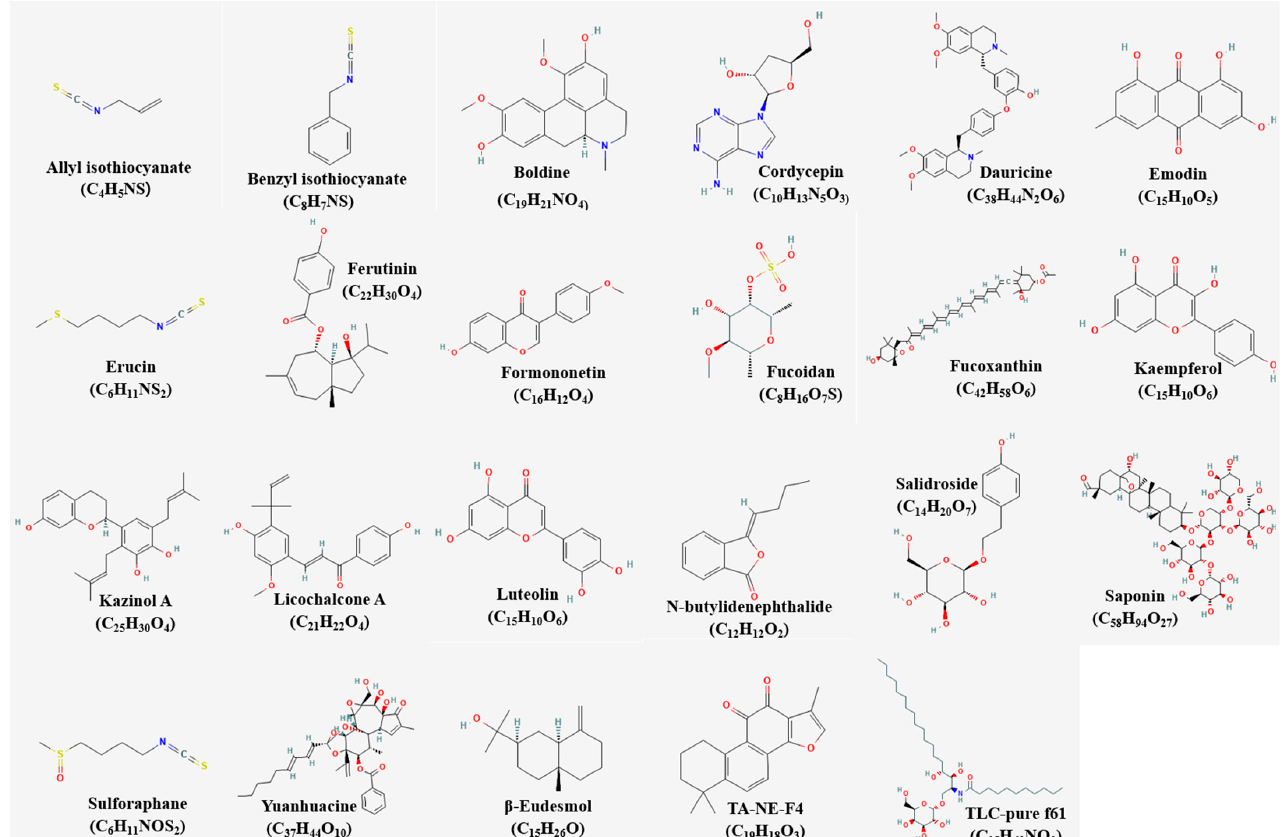
Figure 1. Chemical structures of compounds inducing apoptosis.